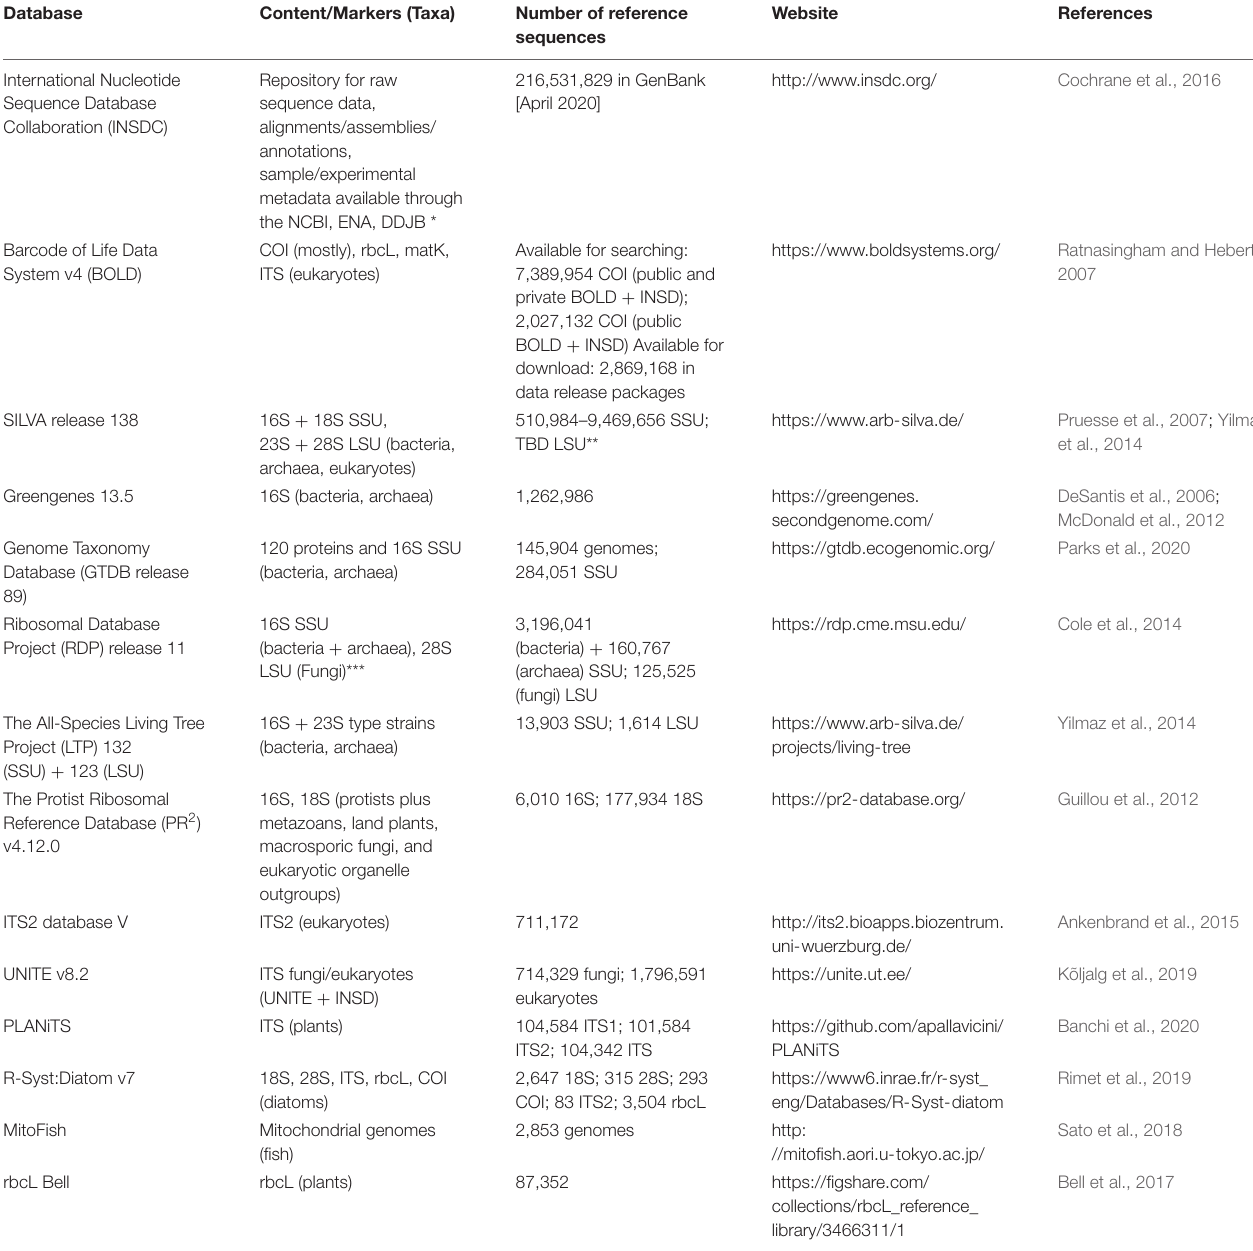
TABLE 2 | Reference sequence databases useful for taxonomically assigning